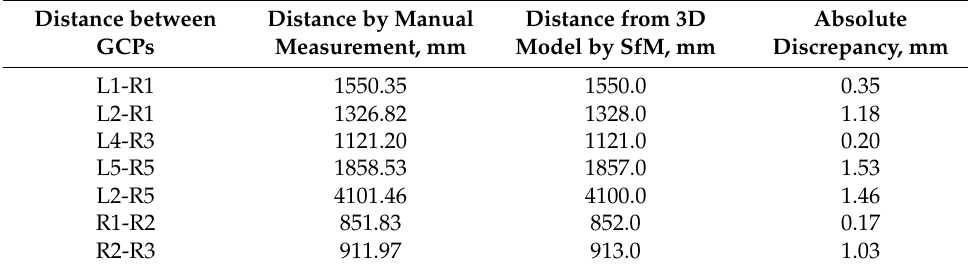
Table 4. Estimated errors in reproduction of selected distances in the 3D model by SfM, Case Study II.